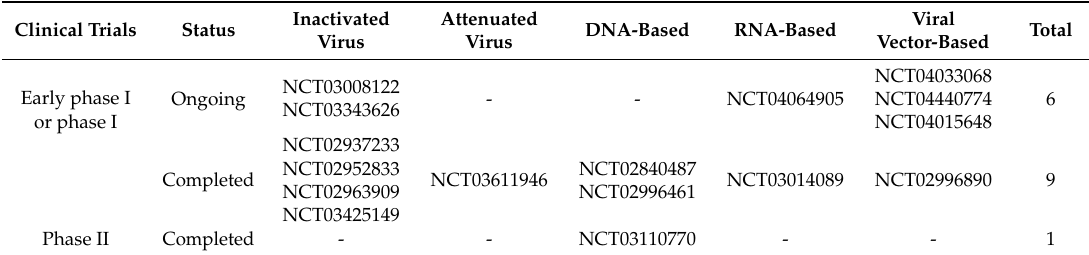
Table 5. ZIKV vaccines in clinical trials.